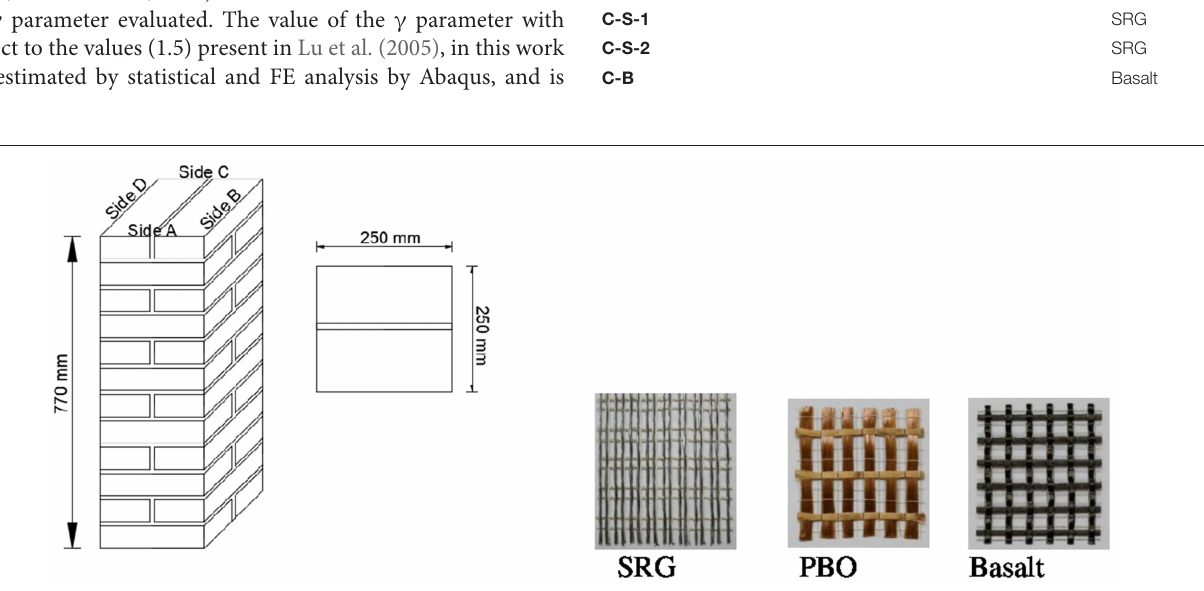
FIGURE 6 | Geometry of the masonry columns and FRCM